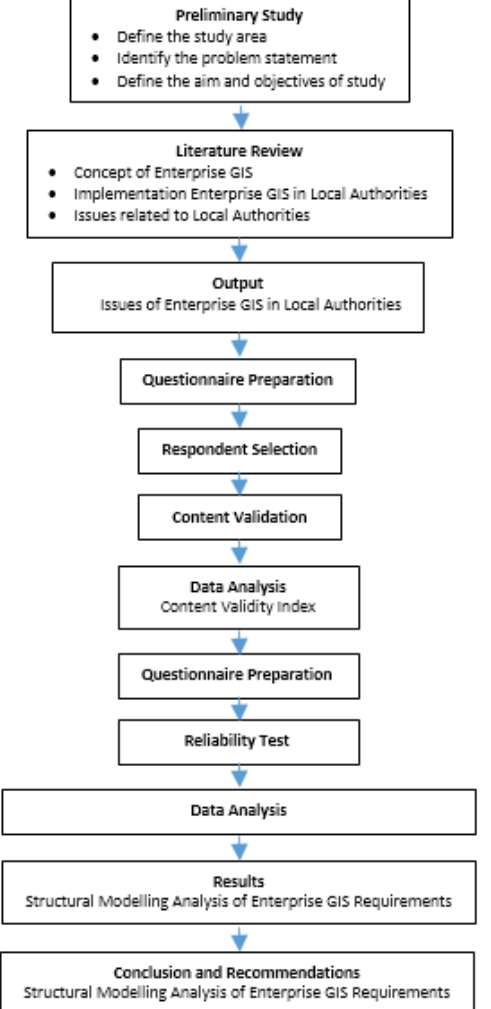
Figure 1. The methodology flowchart of study